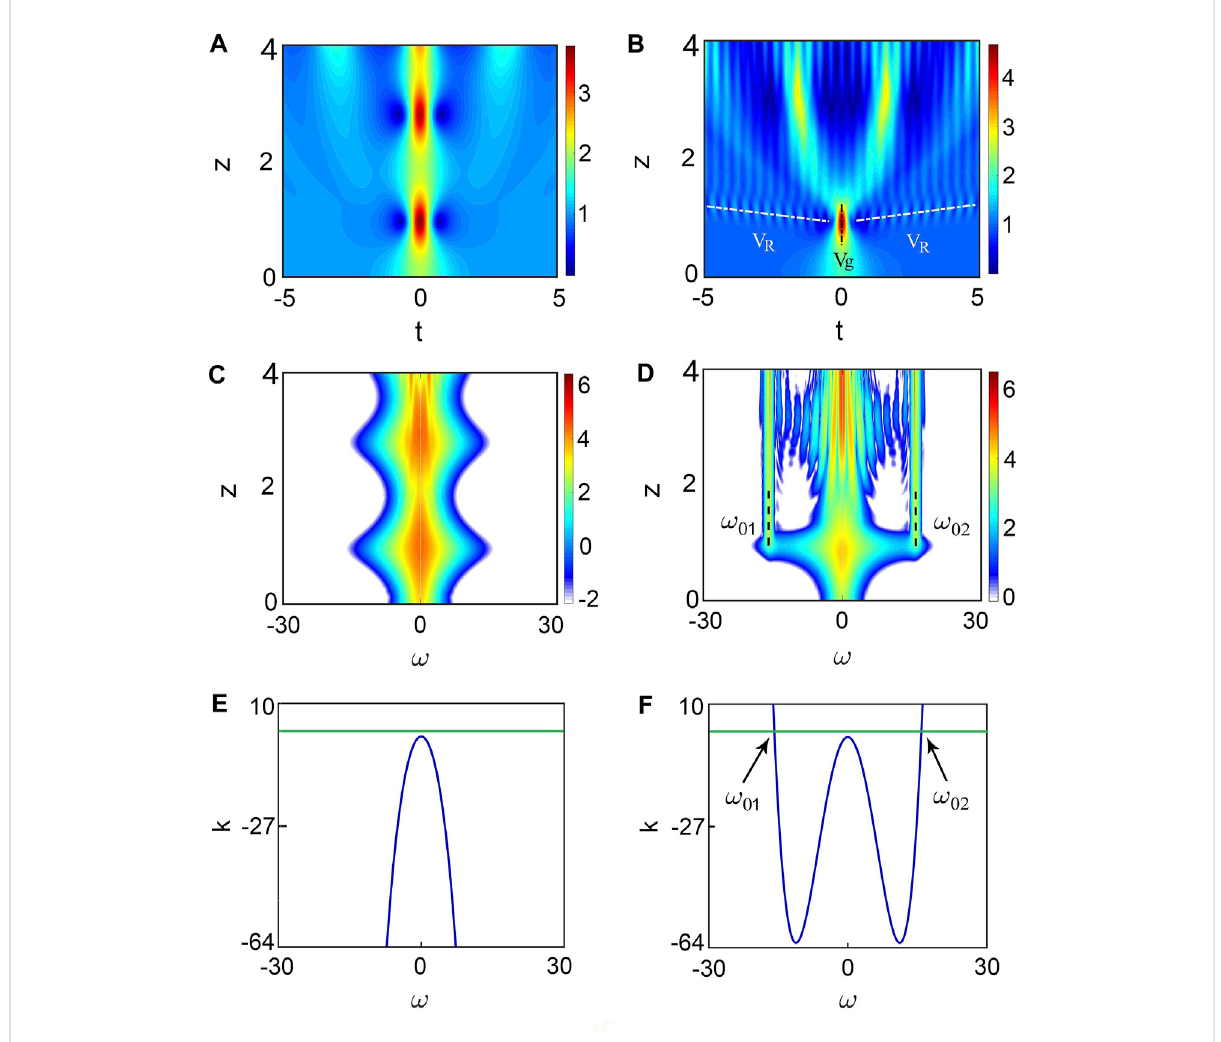
FIGURE 3 Propagation of perturbed KMS without radiations ( β 4 = − 0.096, left column) and with radiations ( β 4 =0.096, right column). (A,B) show the false color plot of spatio-temporal evolution. In (B) , the dashed black line refers to group velocity, and the dashed white line refers to radiation velocity. (C,D) are the corresponding evolution of Fourier spectrum (log scale). (E,F) are graphical solution of Eq. 10. ω 0 j is given by the cross of the green horizontal line standing for k dw , with the blue solid curve signifying the quartic dispersion